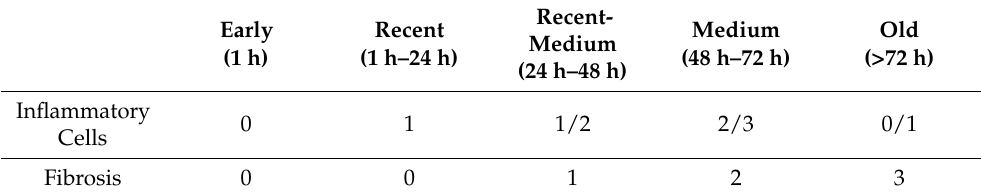
Table 6. Score related to dating thrombus formation according to Mansueto et al.